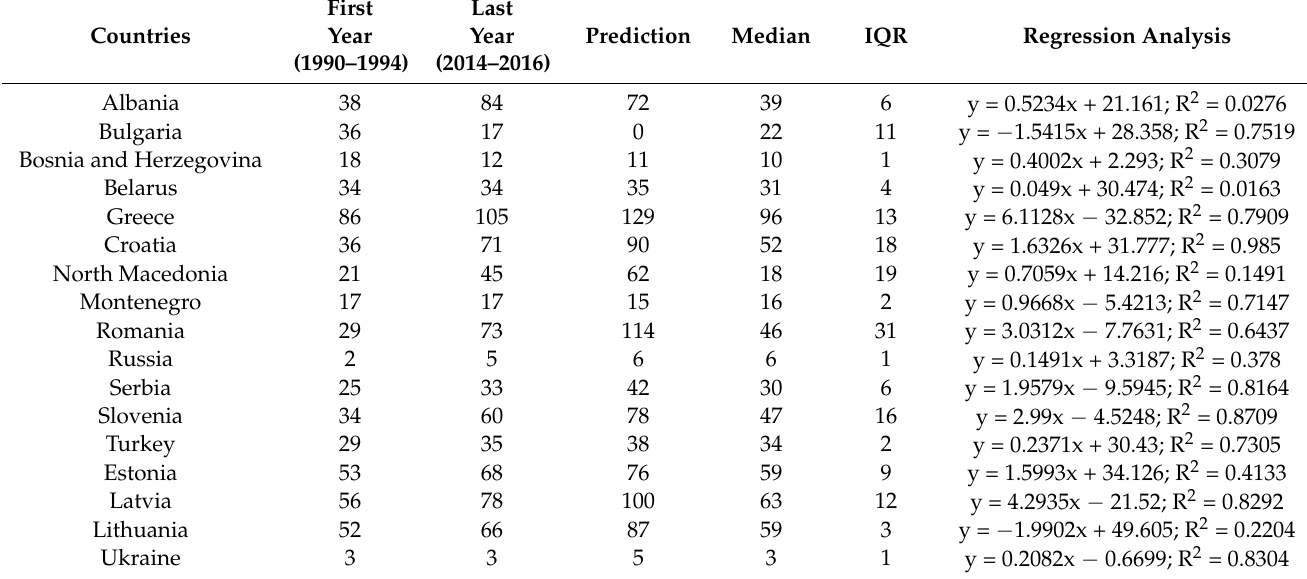
Table 2. Values of the number of pharmacists per 100,000 inhabitants—value of the first observed year, last observed year, predictive value, median value, inter-incremental difference and linear regression